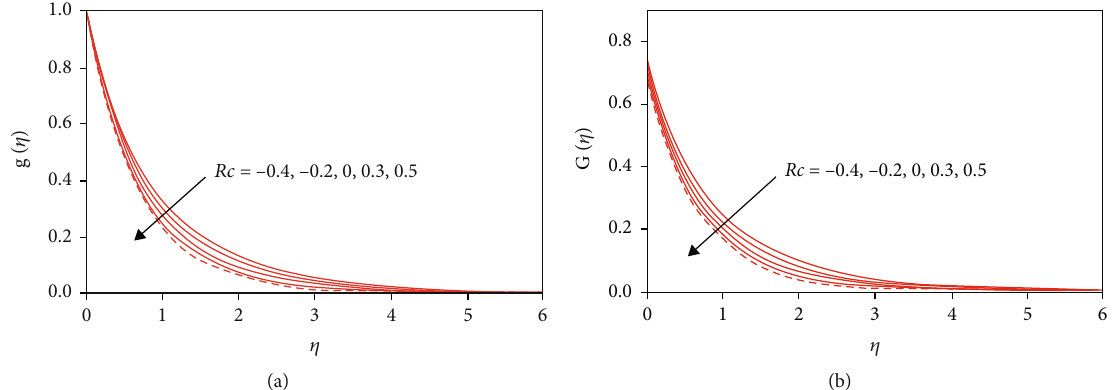
= 0 : 1, Q = 0 and fw = 0 : (a) g in the PST case and (b) 1